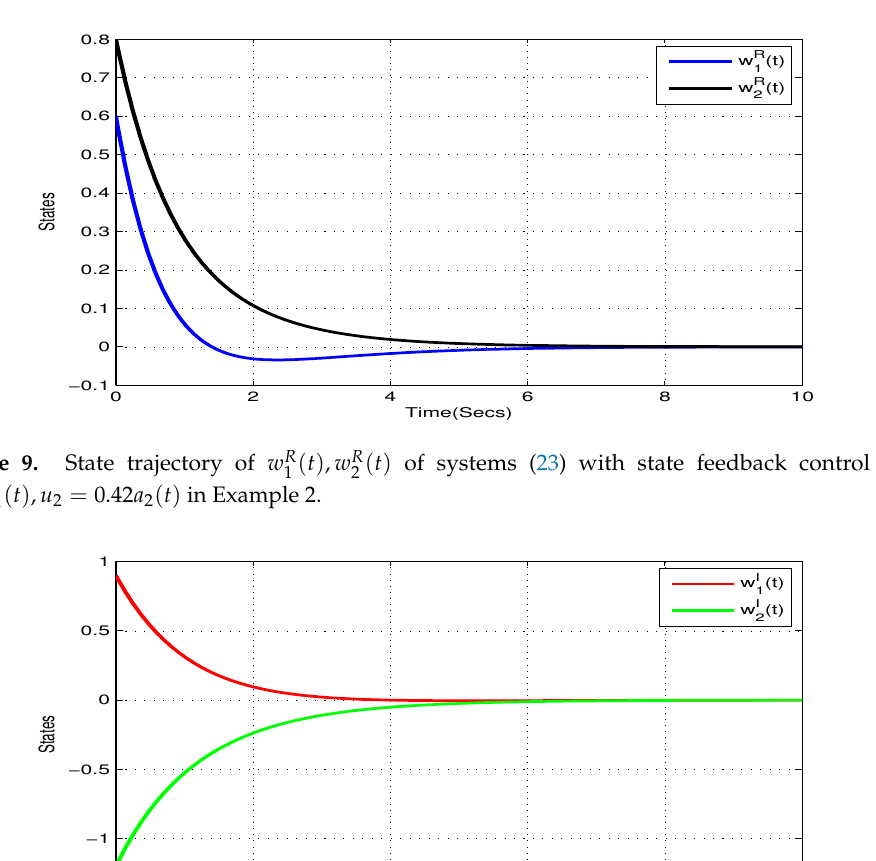
Figure 8. State trajectory of w K Example 2.